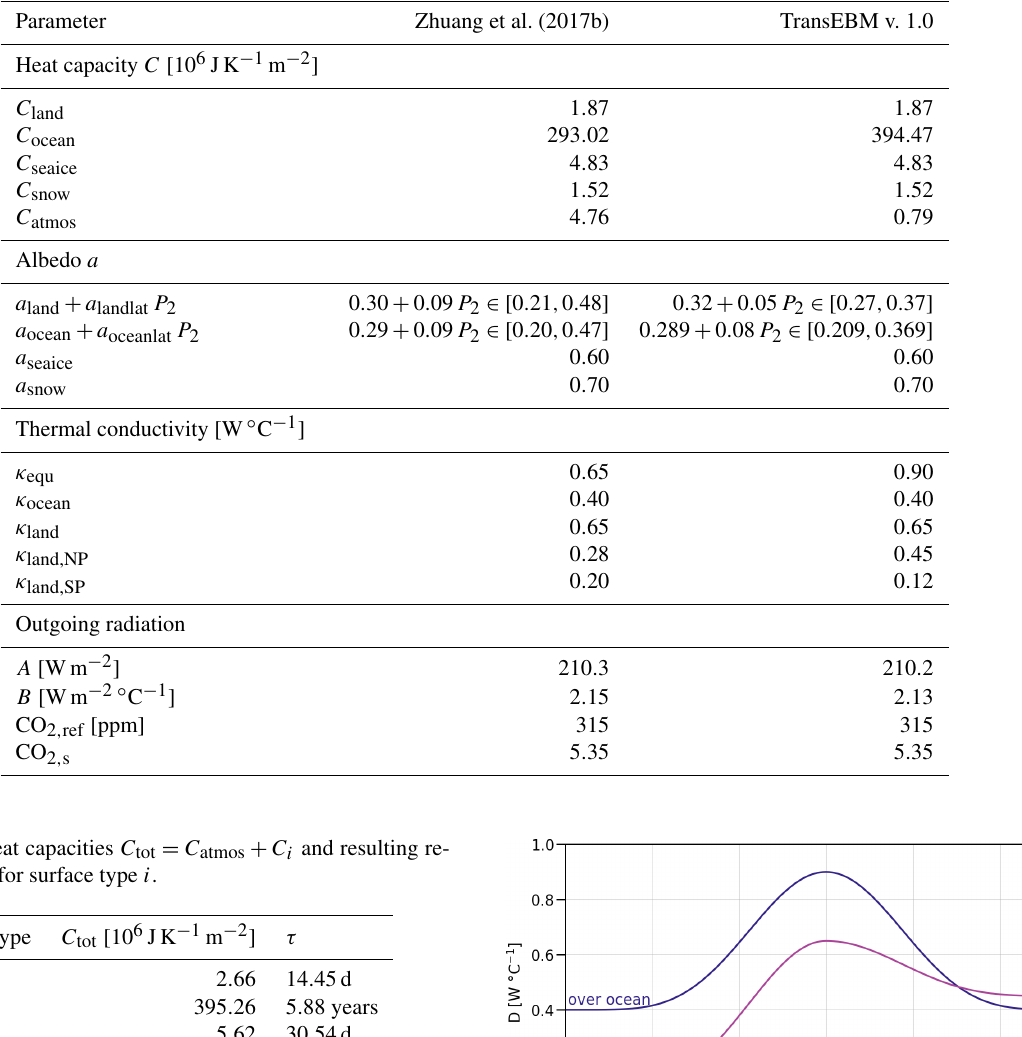
Table 1. List of all model parameters for the model by Zhuang et al. (2017b) and TransEBM v. 1.0 after the tuning described in Sect. 2.4. Albedo over land and ocean depends on latitude θ via the second Legendre polynomial P 2 (θ) = 0 . 5 · ( 3sin 2 (θ) − 1 ) .